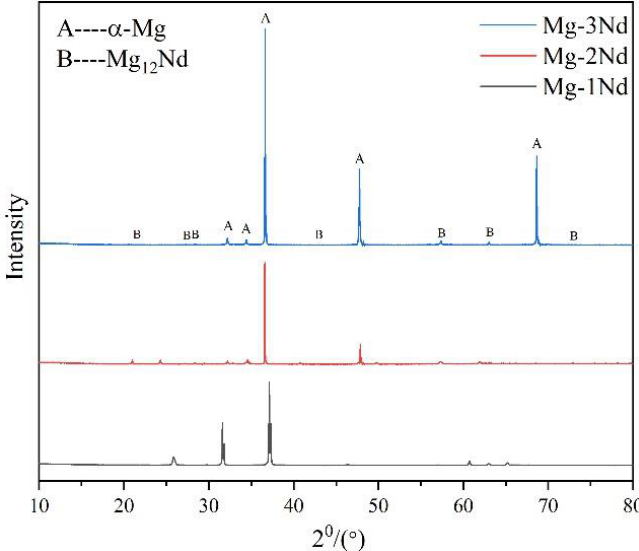
Figure 2. XRD patterns of three Mg – -Nd alloys.